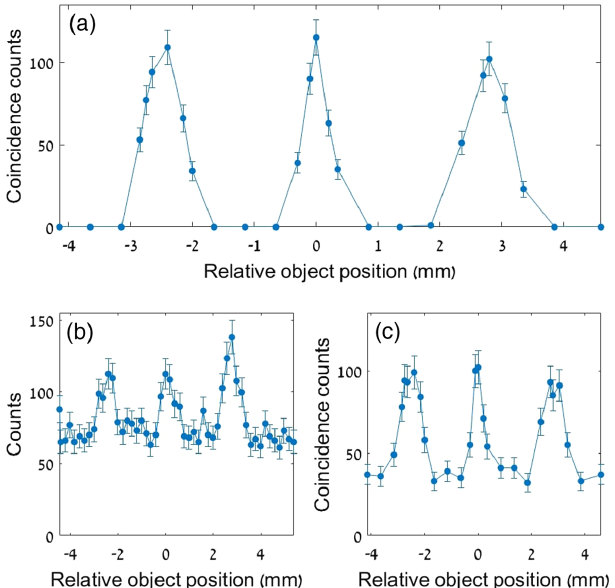
FIG. 3. Reconstruction of the image of the triple slit object by (a) quantum radiation, (b) classical radiation, and (c) classical coincidence counting. The average number of counts is compa- rable in all the panels. In each of the panels, the horizontal axis represents the relative position of the object, and the vertical axis represents the number of events that are detected by the detection system. The error bars are estimated by assuming a Poisson distribution. The solid lines are guides for the